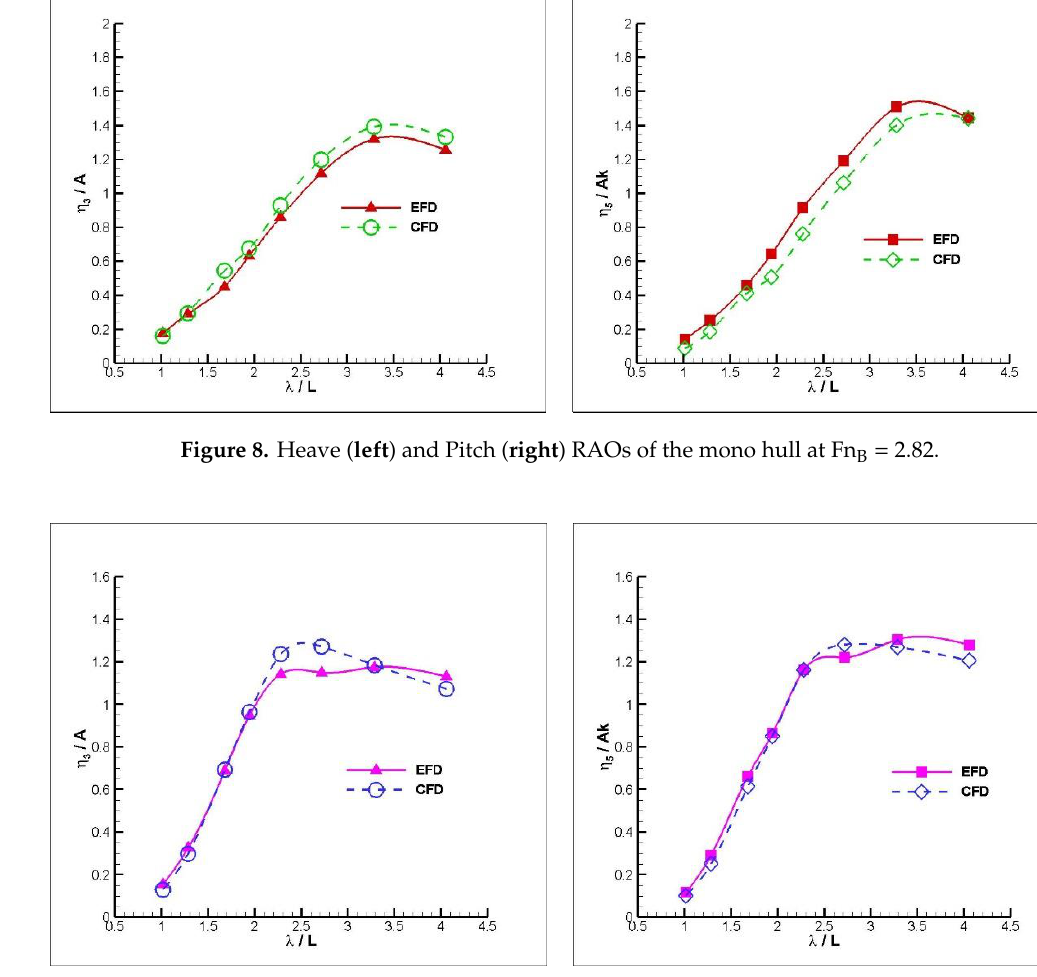
Figure 9. Heave ( left ) and Pitch ( right ) RAOs of the warped hull at Fn B = 1.67.